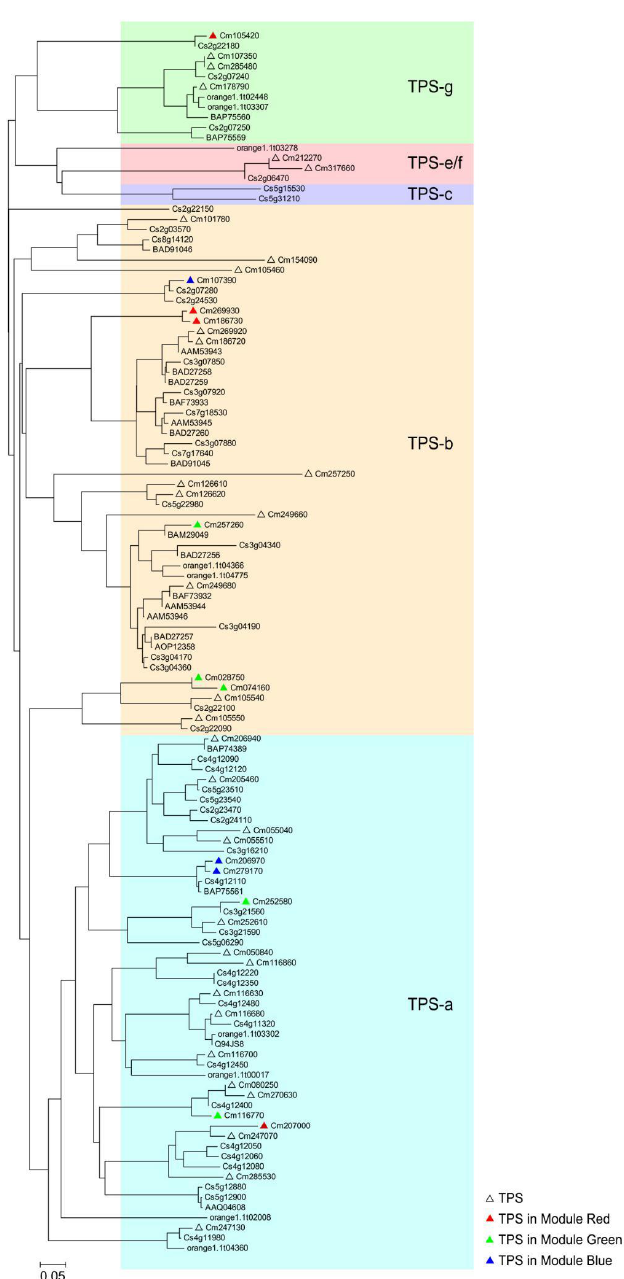
Figure 9. Phylogeny tree analysis of Citrus TPSs. Triangles represent finger citron TPSs, and filled colors indicate their location in modules shown in Figure 5. TPSs accession number of sweet orange and other Citrus species were reported by Alqu é zar et al. [15]. Sequence alignment was performed by ClustalX. Phylogeny tree was visualized by